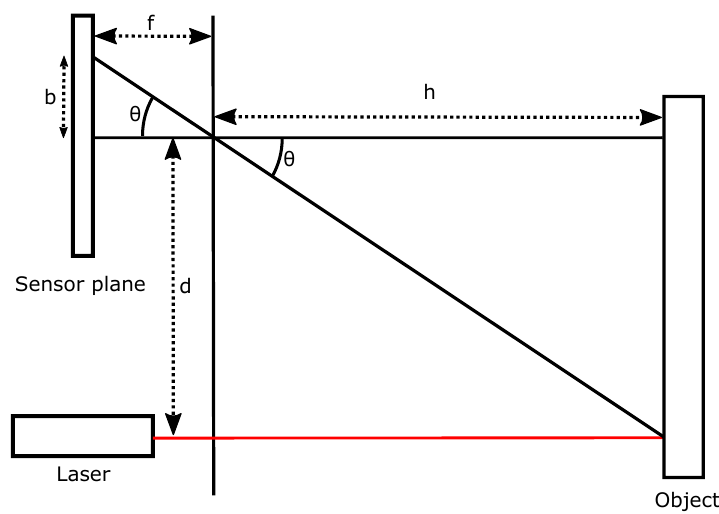
Figure 2. Simple pin-hole triangulation